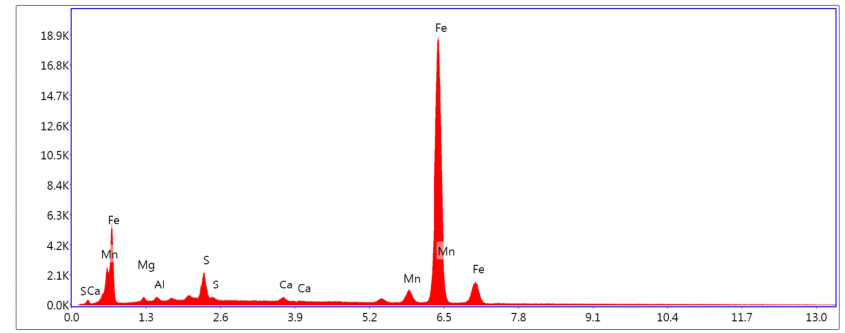
Figure 7. Surface scan of CaS-MnS-Al 2 O 3 inclusions. ( a ) spherical CaS-MnS-Al 2 O 3 inclusion; ( b ) approximate spherical CaS-MnS-Al 2 O 3 inclusion.